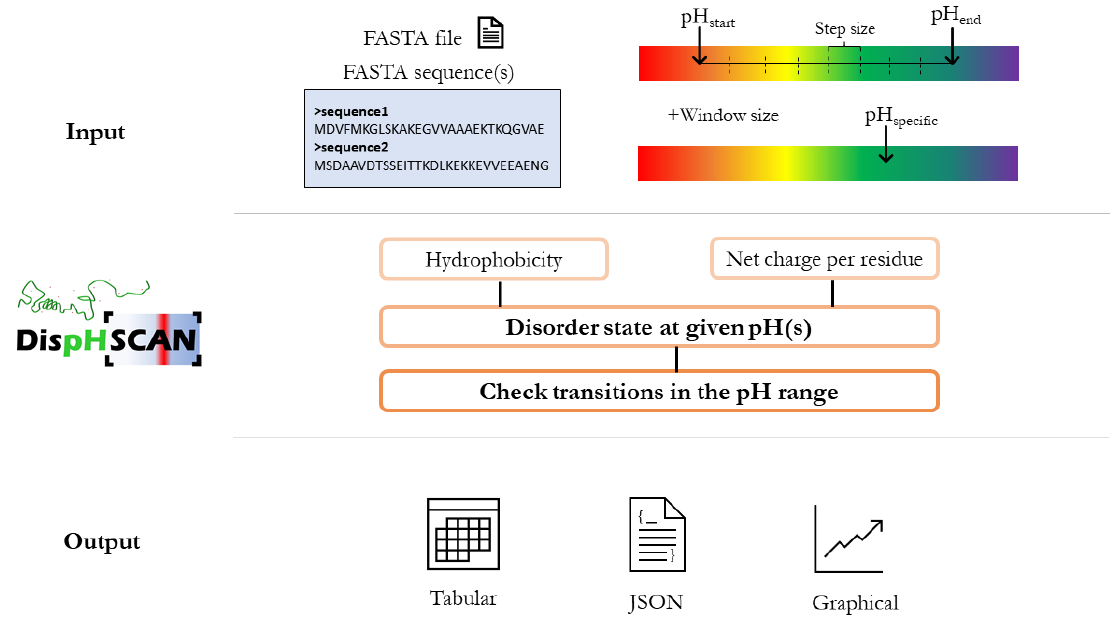
Figure 1. DispHScan pipeline. Users must introduce their sequences in FASTA format and select the pH interval with the desired step and window sizes (default values are 0.5 and 51, respectively). The option of predicting disorder at a single pH is also available. The server computes mean hydrophobicity and NCPR to provide a disorder prediction for each sequence and pH. Possible transitions are checked in the interval of study. The results are represented in both tabular and graphical formats, as well as in JSON; all of them available for download.